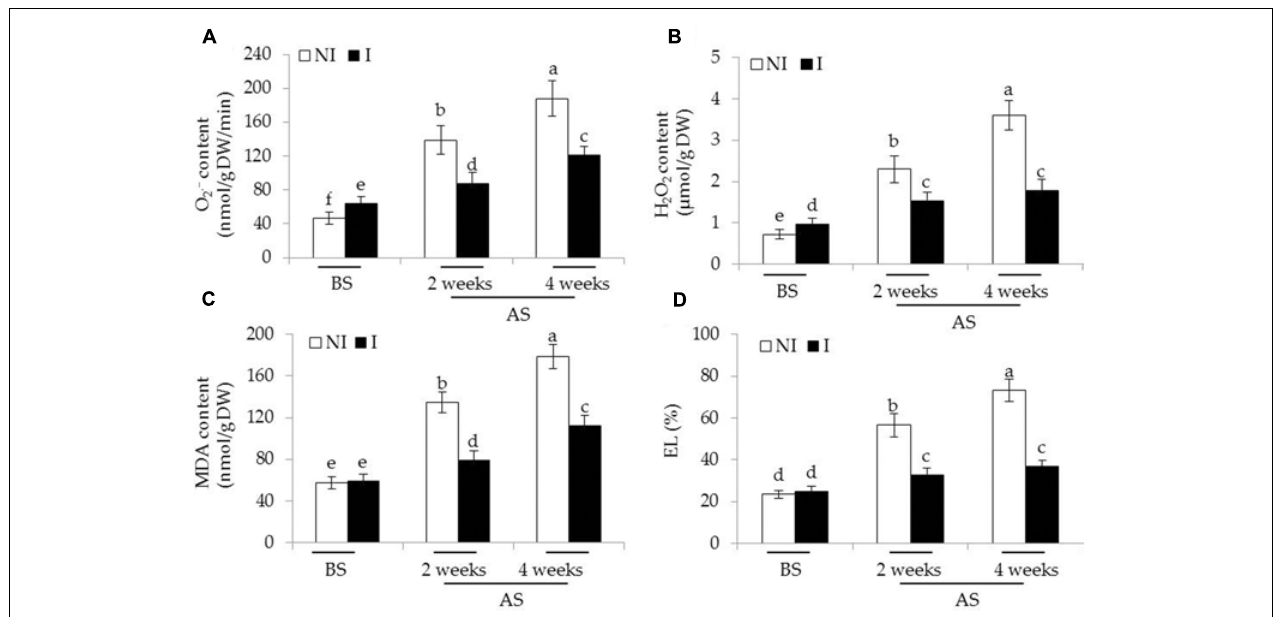
FIGURE 4 | Effects of B. licheniformis SA03 on (A) O •− 2 , (B) H 2 O 2 content, (C) MDA content, and (D) EL in Chrysanthemum plants before (BS) or after (AS) saline–alkaline treatments. Treatments and statistical analysis were as described in Figure 2